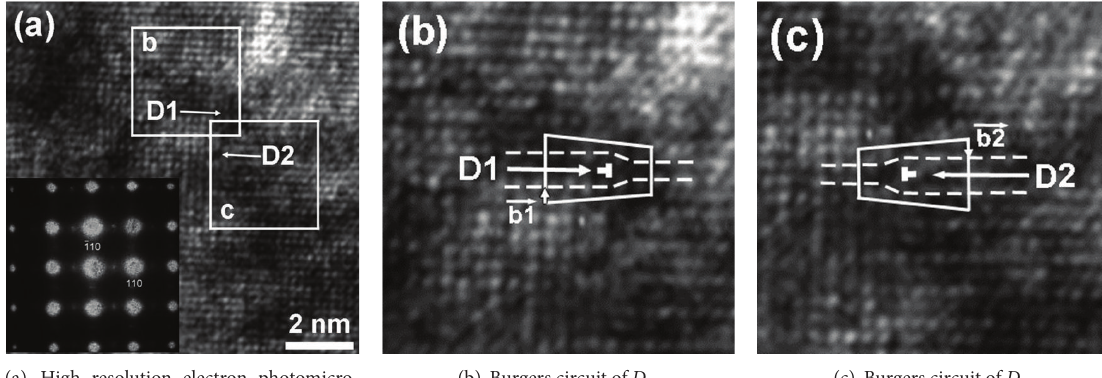
Figure 10: High resolution electron photomicrograph of body-centered cubic